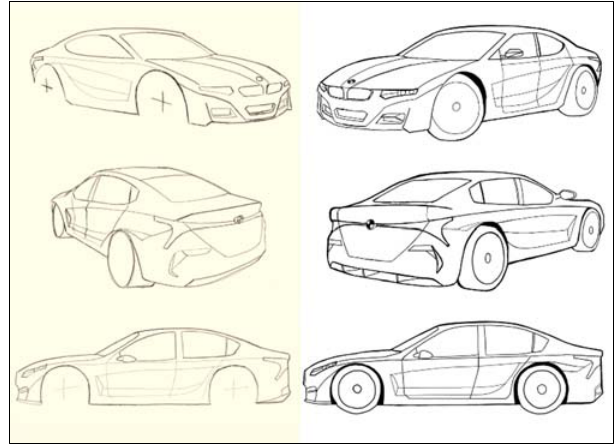
Figure 8. Sketches of the stone proposal.